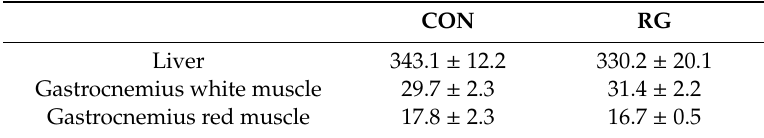
Table 5. Changes in the glycogen concentration ( µ mol / g) in the liver, gastrocnemius white muscle, and gastrocnemius red muscle after 2 weeks of red ginseng (RG) intake.